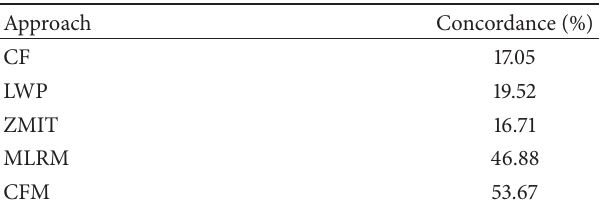
Table 6: Concordance of seasonal regimens of cloud frequency, liq- uid water path, average cloud top height, multiple linear regression model of rainfall, and PCA cloud frequency model of rainfall against C´elleri’s